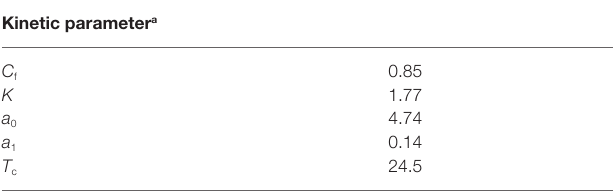
TABLE 3 | Kinetic parameters relevant to the growth of the Lacticaseibacillus paracasei IMPC2.1 strain in the mild processed cabbage for